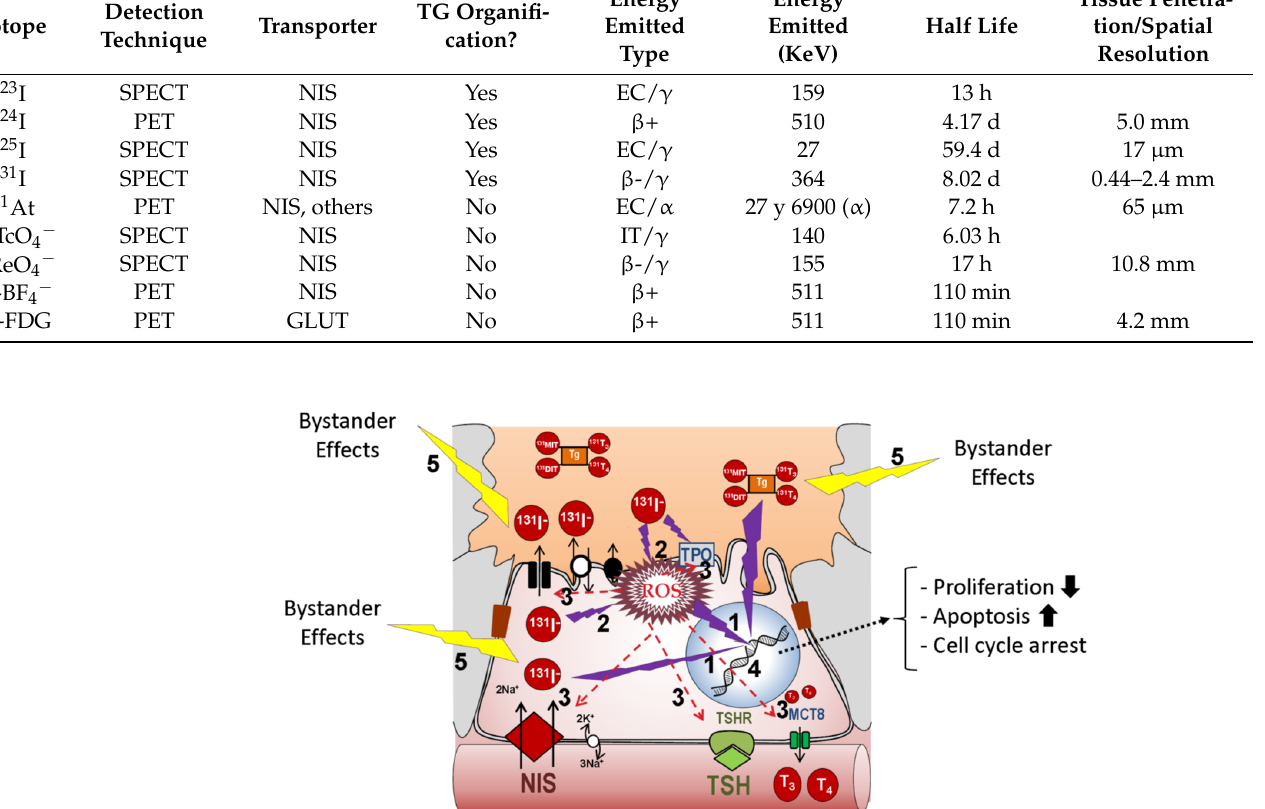
Table 1. Radioactive isotopes used in clinical medicine for thyroid cancer. 18 F-FDG: 2-deoxy-2-[18F]-Fluor-D-glucose; 18 F-BF4-: [18F]-tetrafluoroborate; EC: electronic capture; γ : gamma radiation (high energy photons); β +: positrons from the nucleus; β -: electrons from the nucleus; IT: isometric transition; PET: positron emission tomography; SPECT: single-photon emission computed tomography; TG: thyroglobulin; GLUT: Glucose Transporter. Detection Isotope